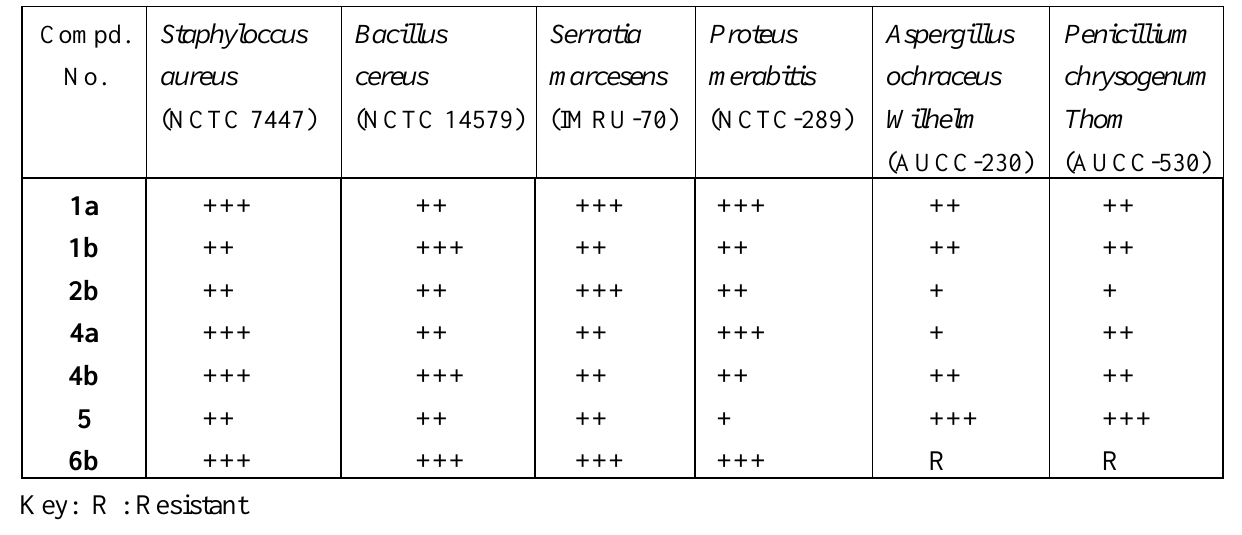
Table 1. Antimicrobial activity of some synthesized